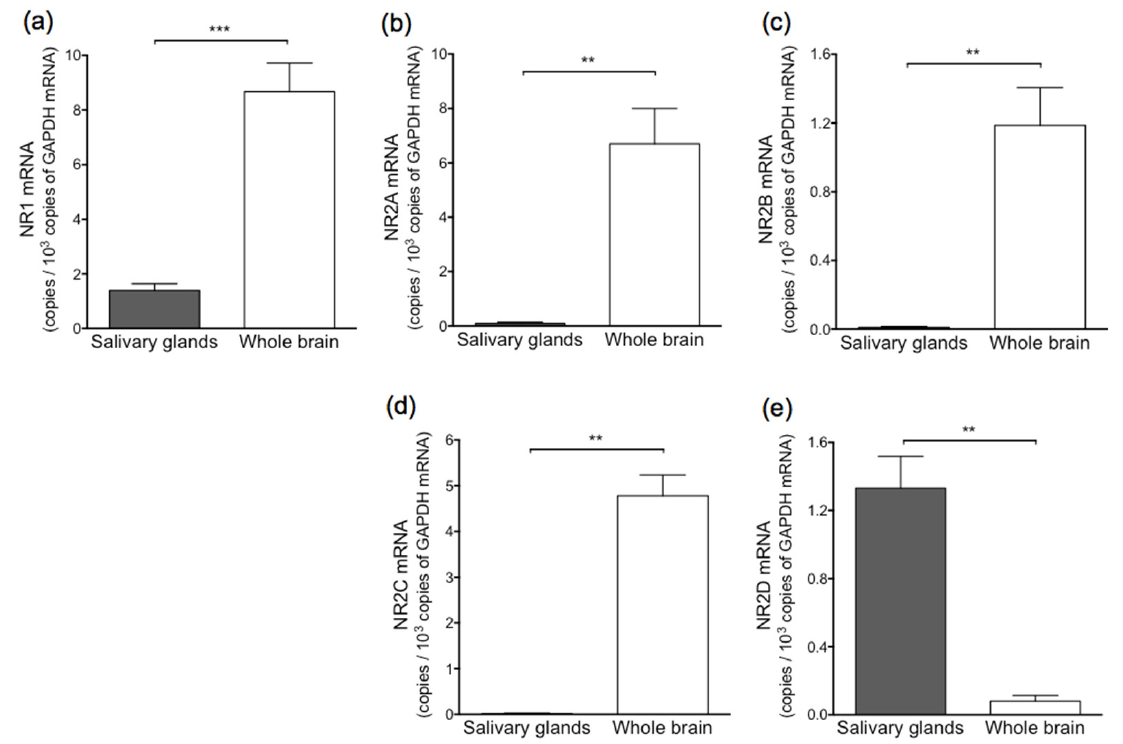
Figure 3. mRNA levels of NR1 ( a ), NR2A ( b ), NR2B ( c ), NR2C ( d ), and NR2D ( e ) in mixture of three salivary glands and whole brain of rat. Values represent mean ± SD in 5 rats. Significantly different according to Mann–Whitney test between two groups; ** p < 0.01, and *** p < 0.001.